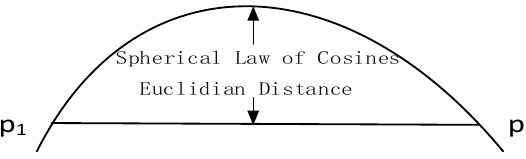
Figure 2. Distance calculation methods: Euclidian distance and the spherical law of cosines.